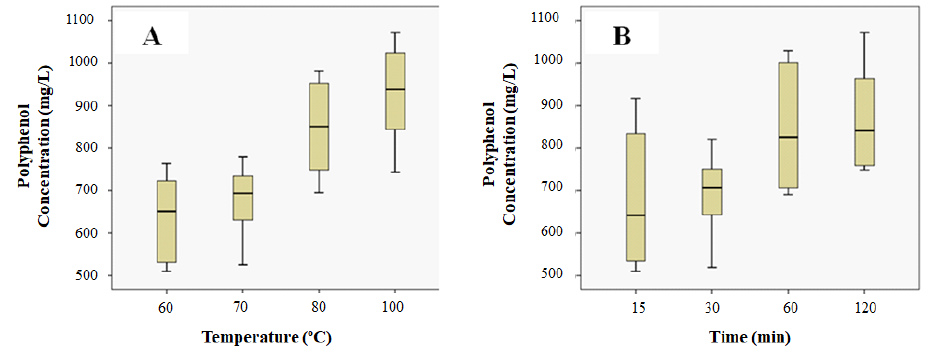
Figure 1. BP for the concentration of polyphenols at different temperatures ( A ) and contact times ( B ).